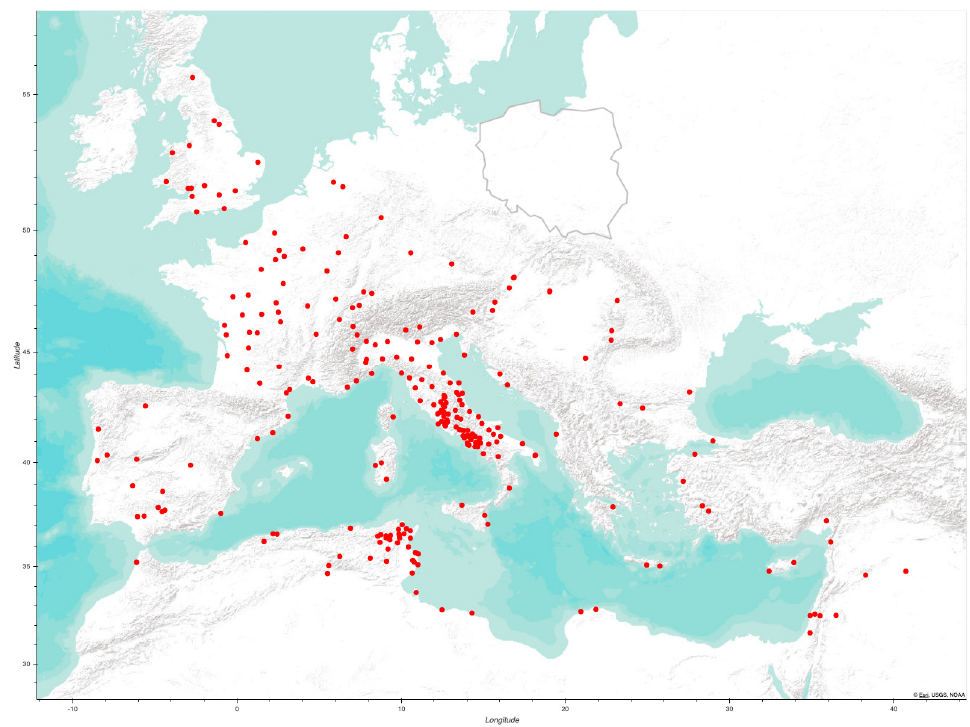
Figure 2. Distribution of amphitheaters in the Roman Empire. Adapted from ref.